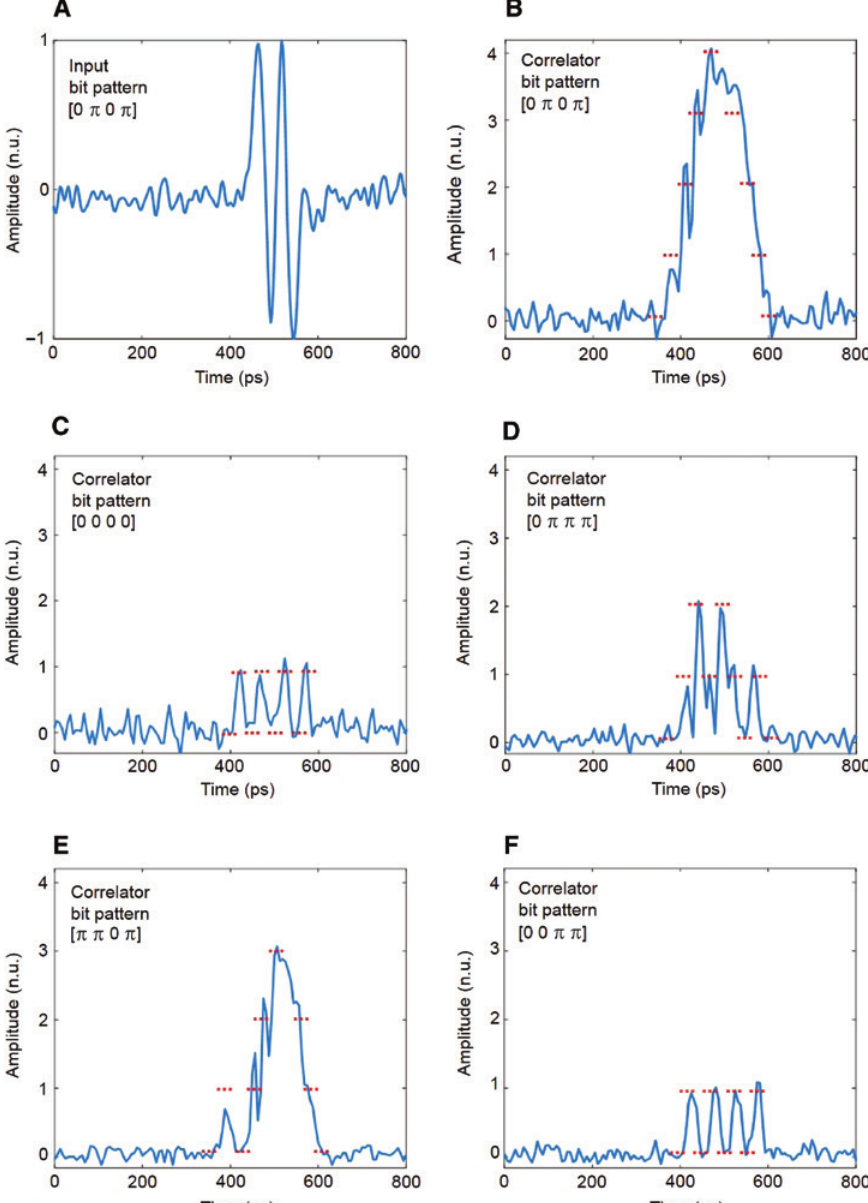
Figure 13: (A) Input signal amplitude with bit pattern [0, π , 0, π ]. (B–F) Correlator outputs with correlator bit patterns (B) [0, π , 0, π ]; (C) [0, 0, 0, 0]; (D) [0, π , π , π ]; (E) [ π , π , 0, π ] and (F) [0, 0, π , π